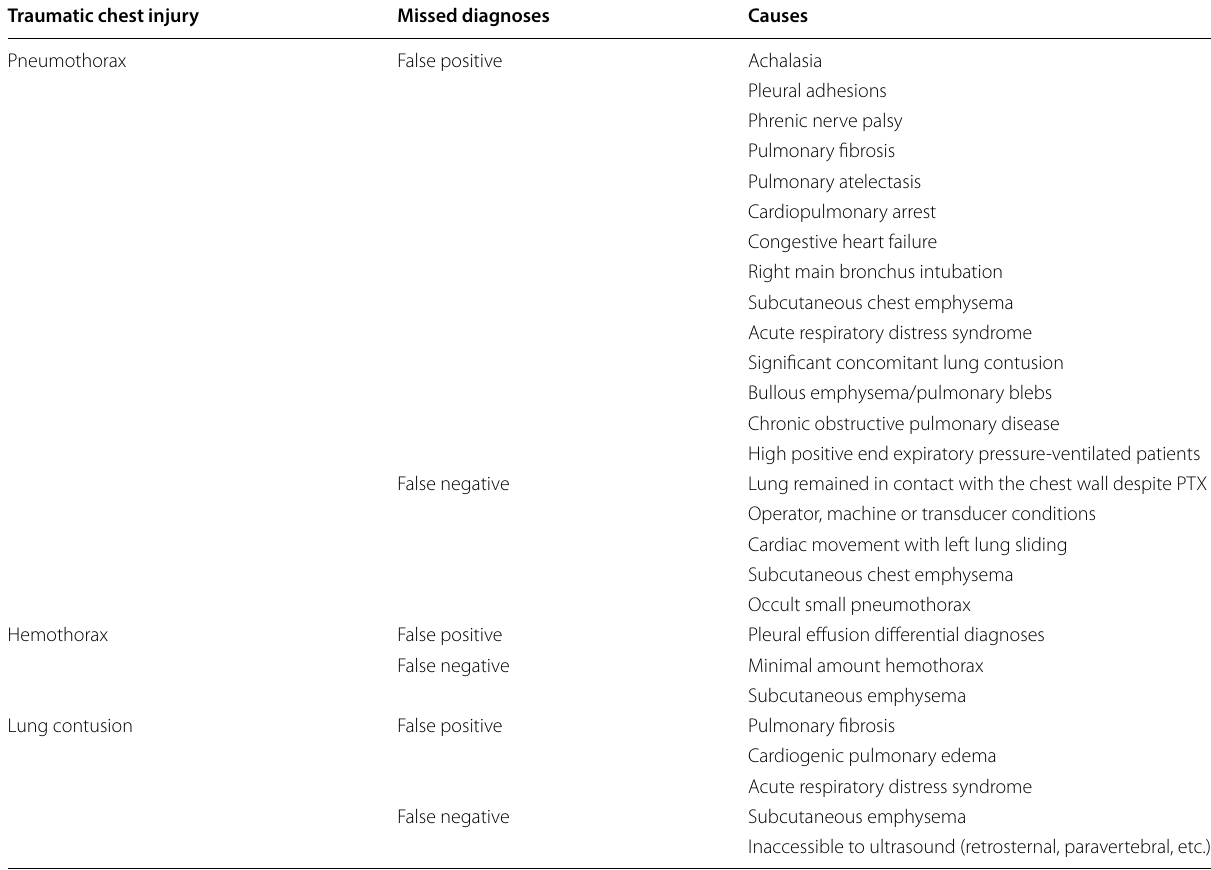
Table 4 Possible suggested causes for false-positive and negative results of bedside ultrasonography for the diagnosis of traumatic chest injuries